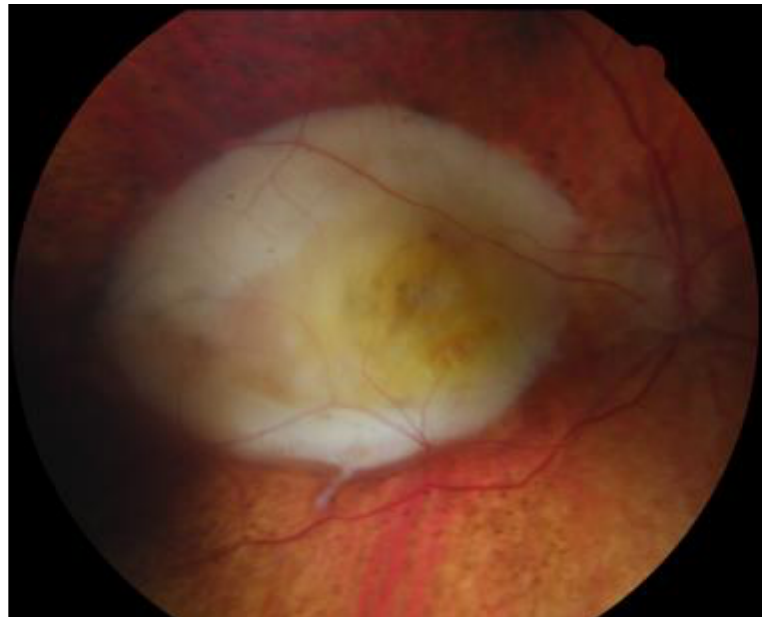
Figure 8. Disciform scar.